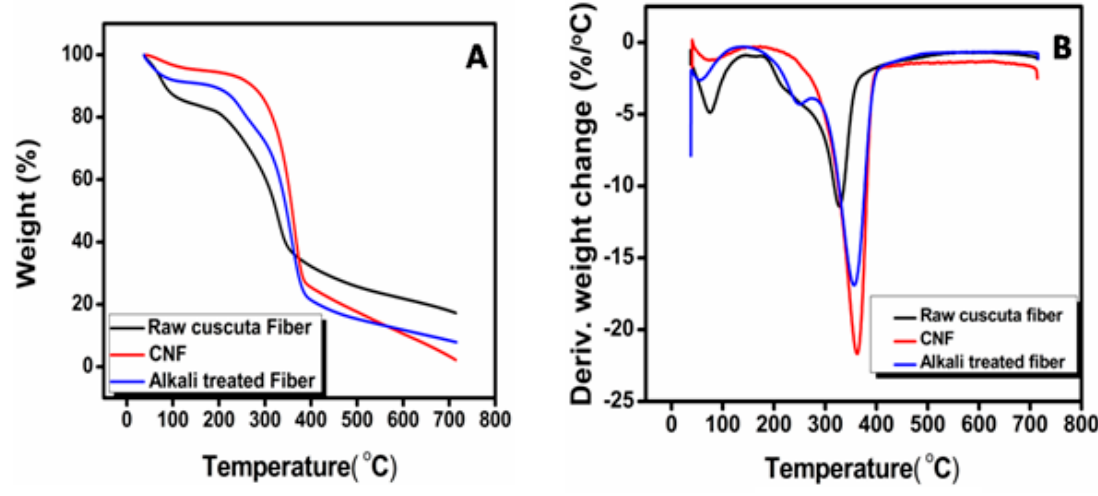
Figure 5. A —TG and B —DTG curves of CNF.